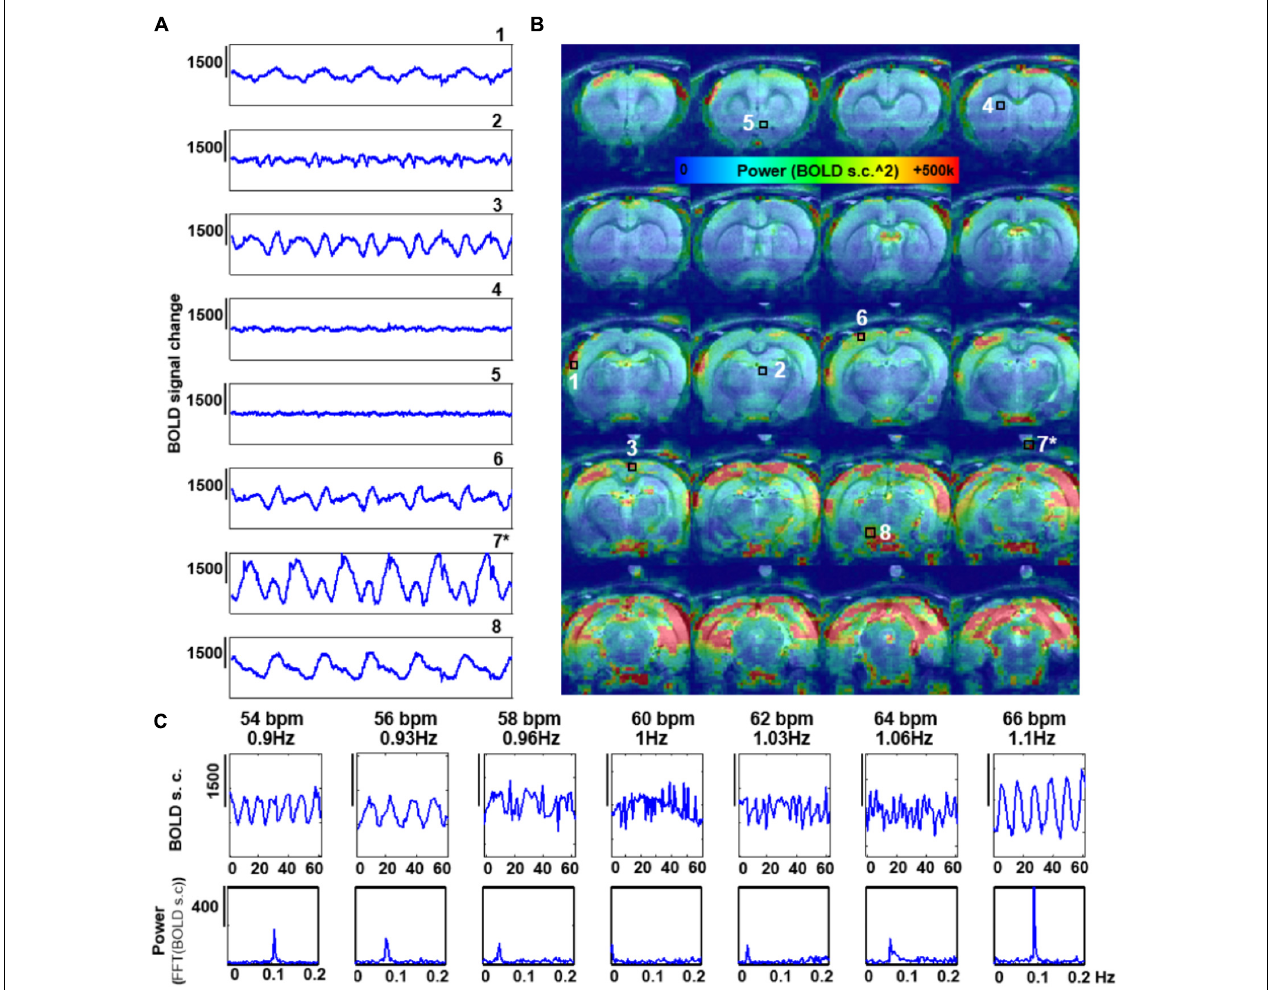
FIGURE 4 | Effect of the rate of artificial ventilation on the fMRI time-course. (A) The graphs show 300 s of fMRI time course from 8 different voxels, extracted from a 3D EPI in an animal ventilated at 59 bpm (0.96 Hz) (TR = 1 s). Numbers indicate the location of the voxels (see C). ( ∗ ) indicates a phantom voxel (registration is not perfect due to misalignment between the anatomical and functional scan). (B) The map shows the distribution of the power of frequencies in the range 0.005–0.4 Hz. (C) fMRI time courses acquired with TR = 1s in a non-paralyzed animal ventilated at seven different